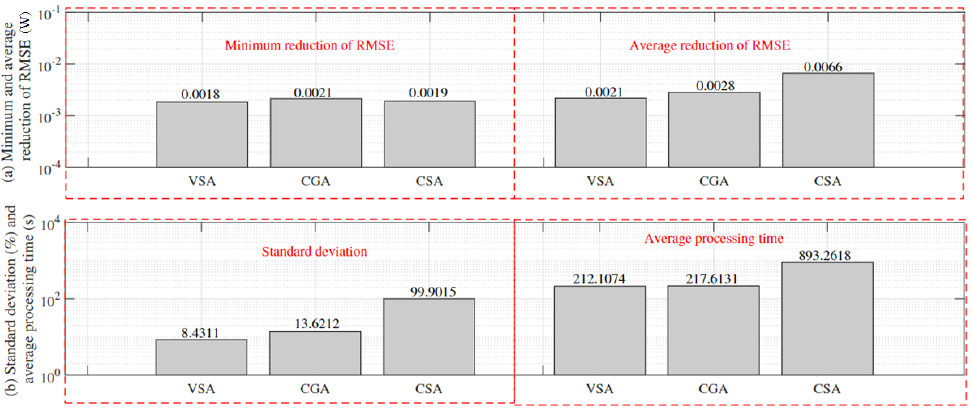
Figure 5. Reductions obtained by the master–slave methodologies: ( a ) minimum and average reduction of RMSE. ( b ) Standard deviation (%) and average processing time